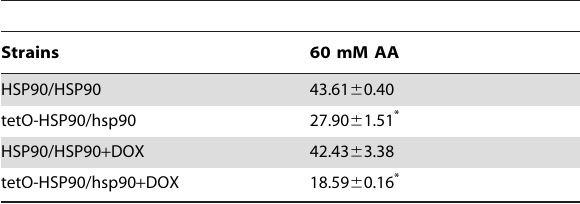
Table 6. Caspase activity of C. albicans cells after AMB treatment 6 .